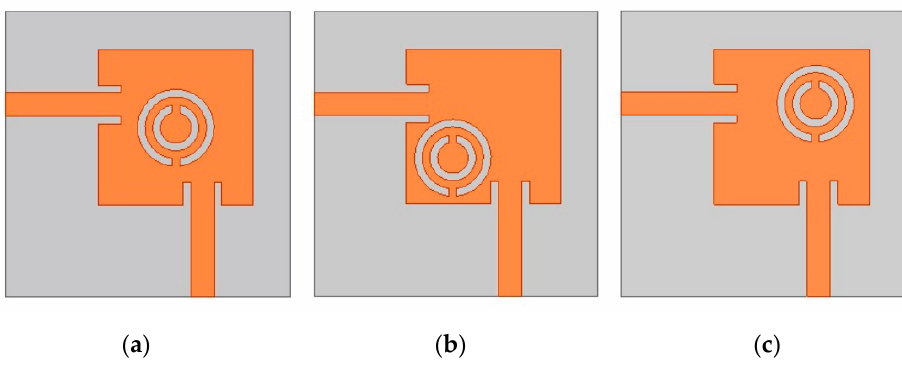
Figure 4. Three different CSRR element positions on the proposed microstrip planar circuit patch: